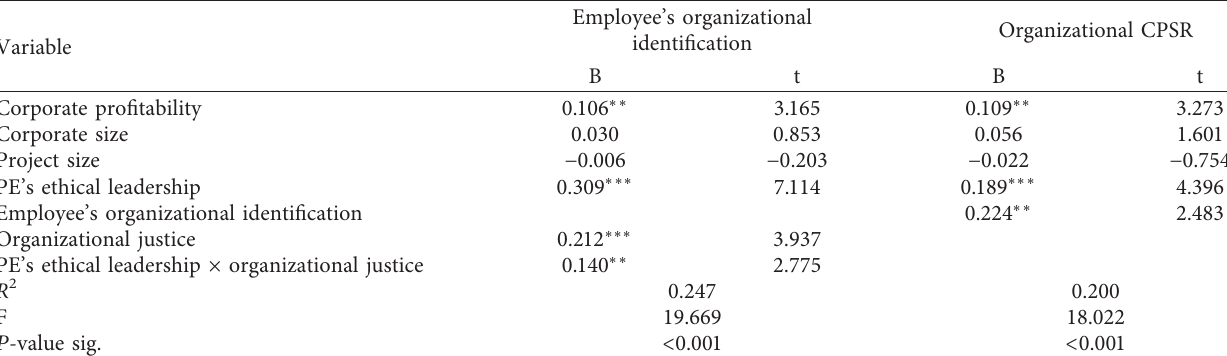
Table 6: Results of moderation